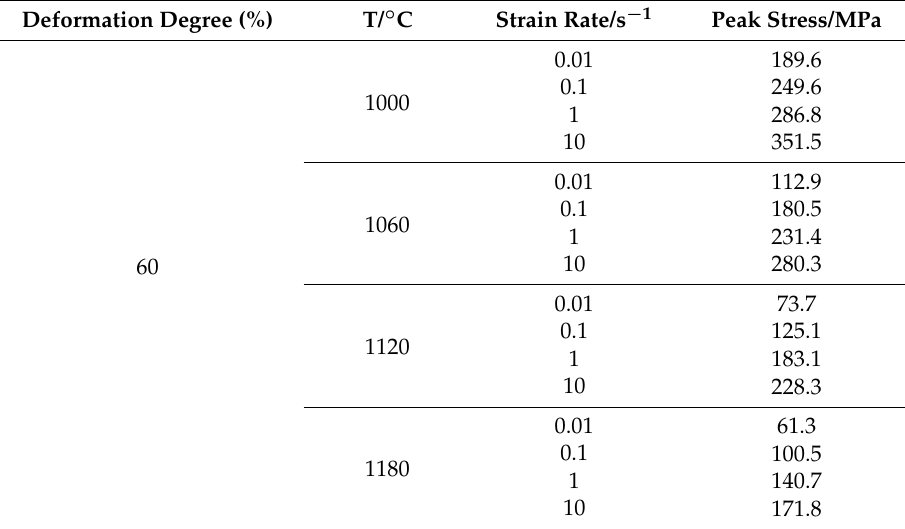
Table 2. Peak stress of the modified 21-4N heat-resistant steel. Deformation Degree (%) T/ ◦ C Strain Rate/s − 1 Peak